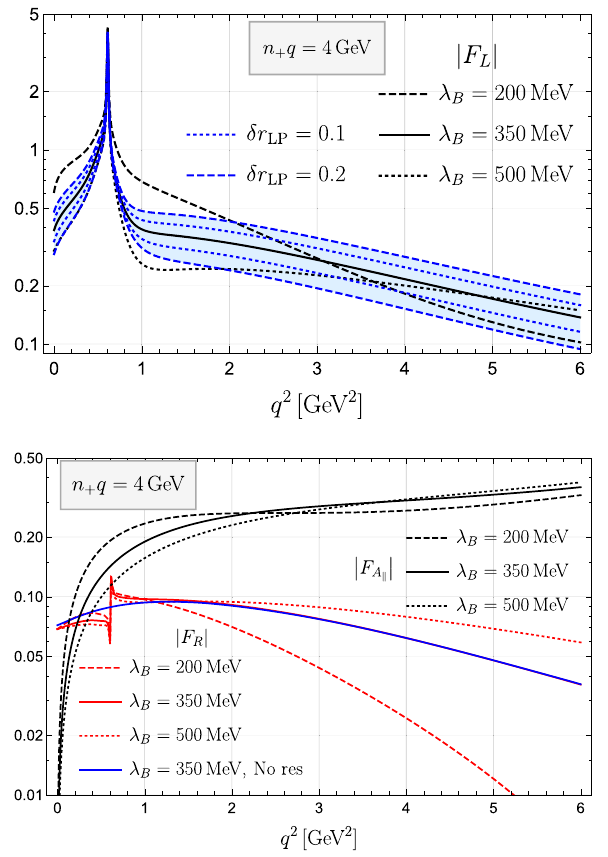
Fig. 5 The q 2 dependence of the form factors at fixed n + q = 4 GeV for three values of λ B from 200 MeV (dashed) to 500 MeV (dotted). In addition, for | F L | (upper panel) we show the uncertainty from varying for the central value r LP by δ r LP = 0 . 1 ( 0 . 2 ) . For the NLP form factors (lower panel), we show | F R | for both, with and without the resonance